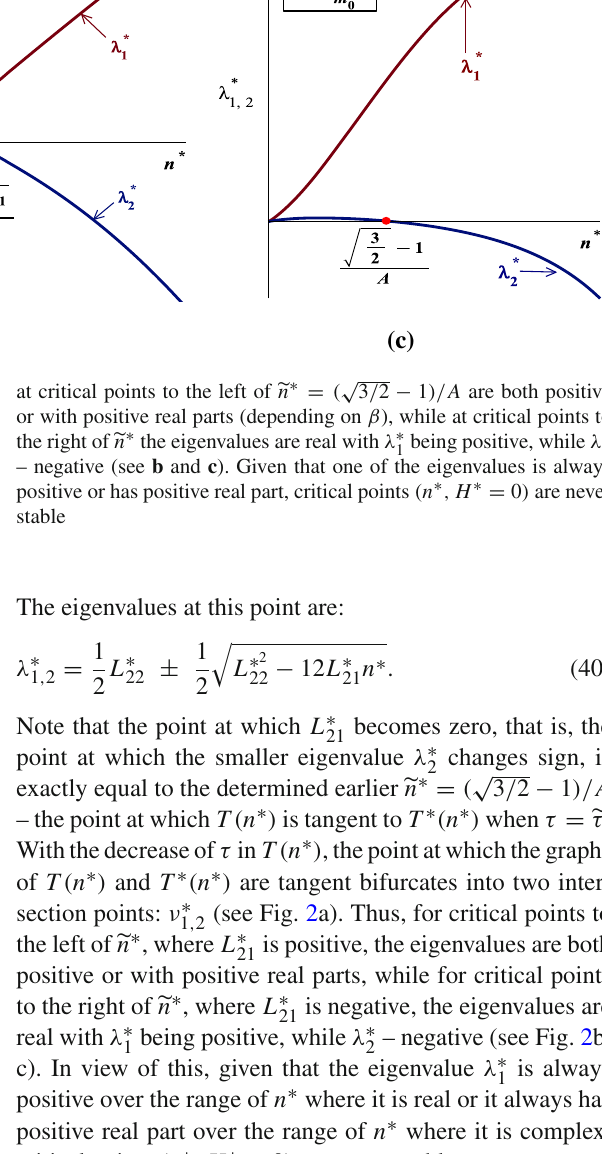
√ 3 / 2 − 1 )/ A are both positive being positive, while λ ∗ 1 2